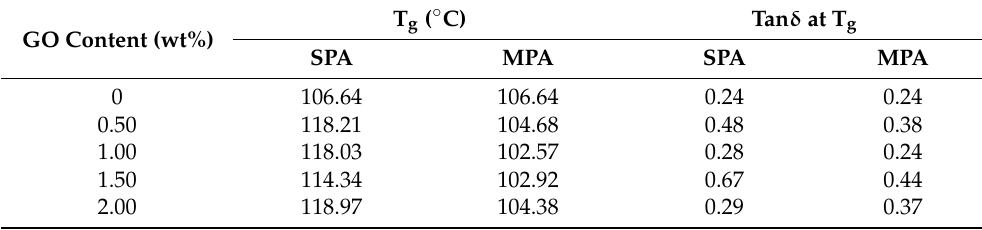
Table 4. Main thermomechanical parameters of SPA and MPA composites with different GO